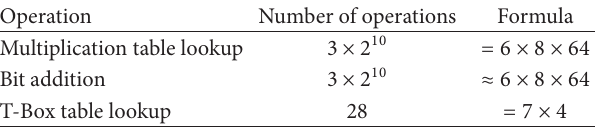
T-Box table lookup Table 2: Number of operations in the fast software implementation of SHARK 𝑊 [𝐾]